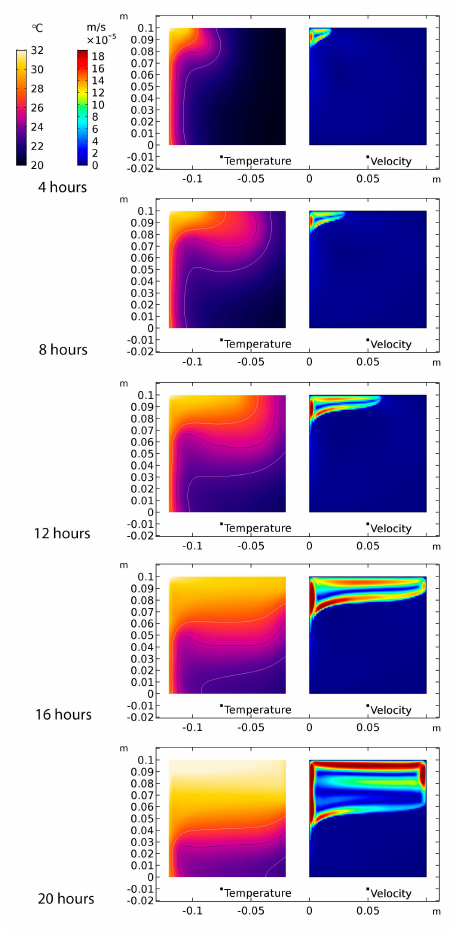
Figure 9. Results of the step 1 simulation after 4, 8, 12, 16 and 20 h (from top to bottom); black line in temperature contour plot is the 25 ◦ C isotherm; white lines are the 23 ◦ C respectively 27 ◦ C